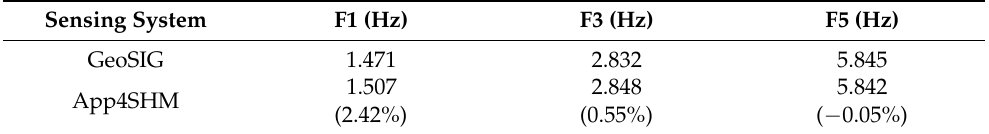
Table 7. Comparison between GeoSIG and App4SHM sensing systems throughout an ambient vibration test (old bridge).